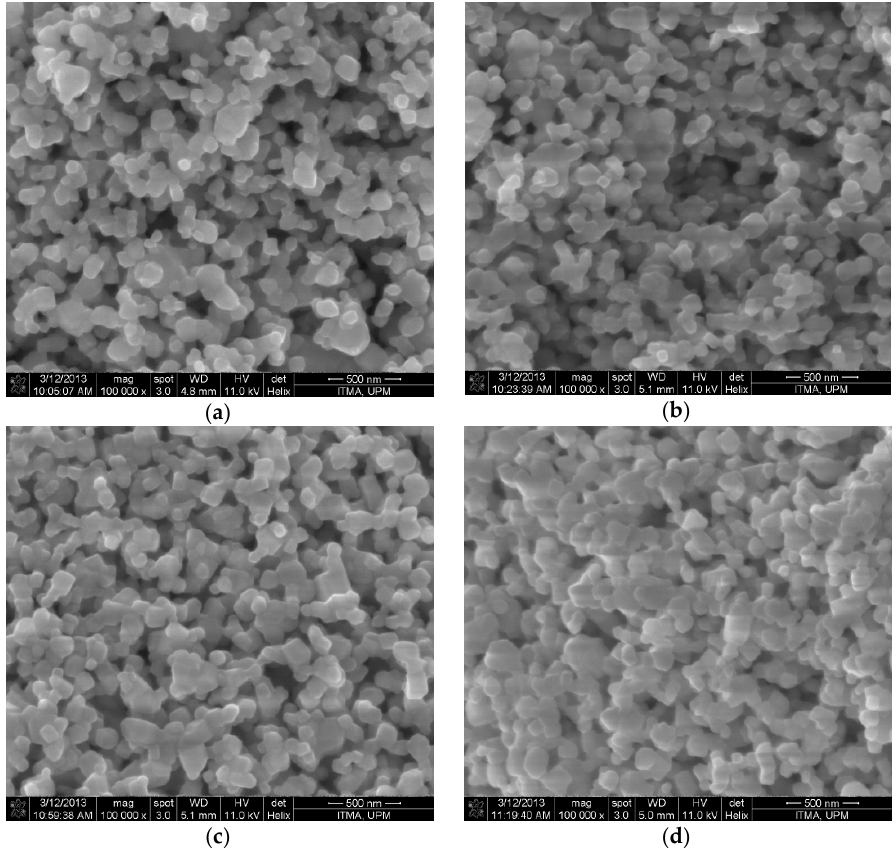
Figure 1. FESEM micro-photograph of four types of sensors annealed at 1100 °C: ( a ) ZST; ( b ) ZST doped 1 mol% MgO; ( c ) ZST doped 3 mol% MgO; ( d ) ZST doped 5 mol%